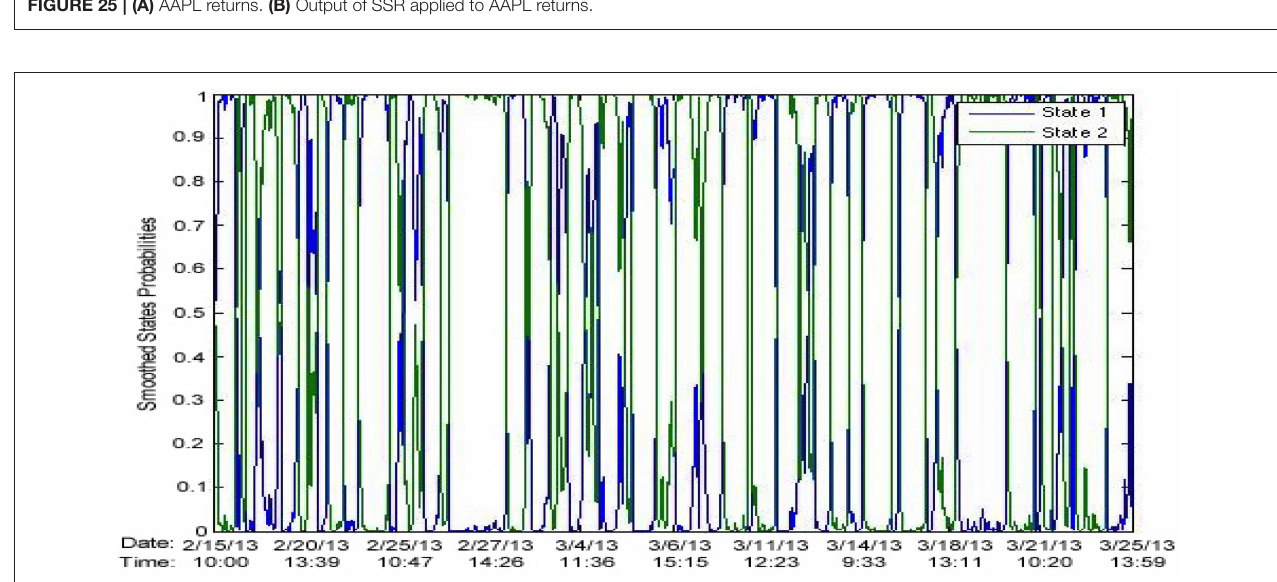
FIGURE 26 | State probabilities over time with noise intensity of